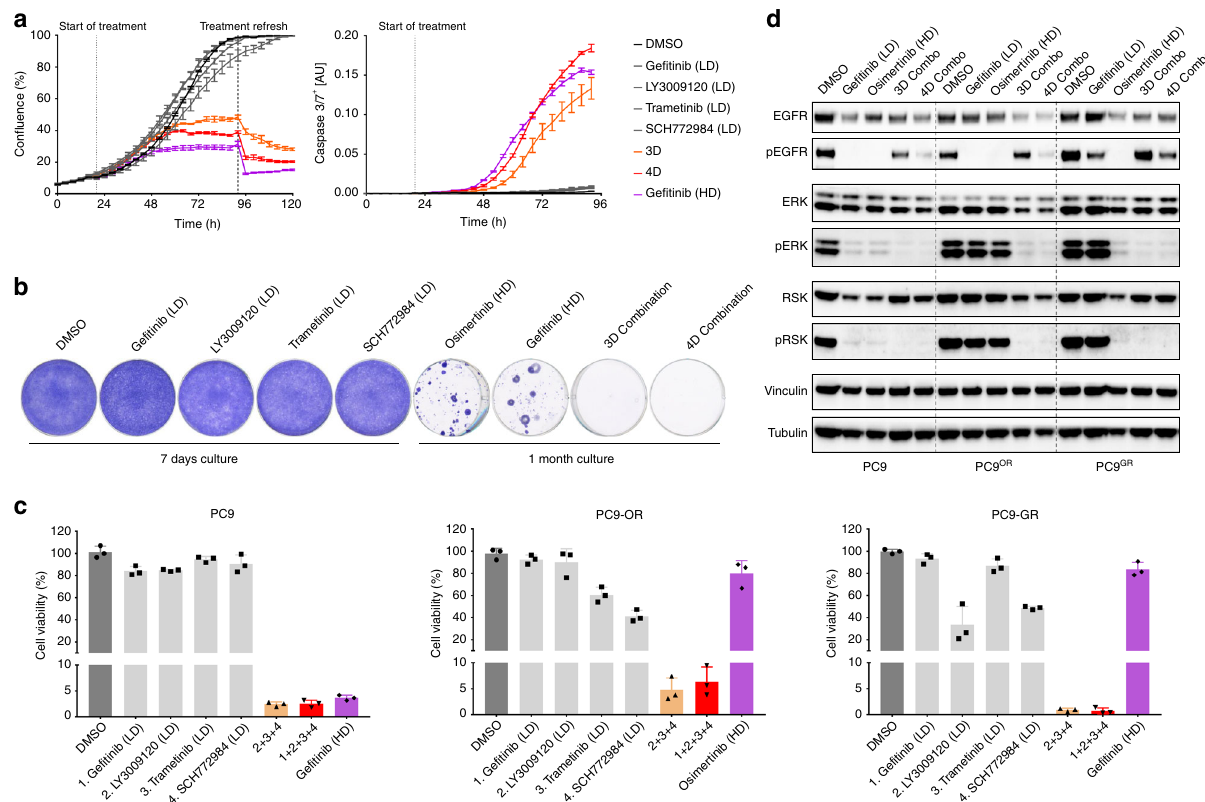
Fig. 2 MLD therapy minimises therapeutic resistance and is effective in EGFRi-resistant PC9 cells. a MLD therapy abrogates cell proliferation and induces apoptosis in PC9 cells. PC9 cells were plated and incubated overnight to allow attachment to the plate. Cells were then treated with DMSO, with EGFR, RAF, MEK, ERK inhibitors at low dose, with 3D Combo (RAF + MEK + ERK inhibitors at LD) or with 4D Combo (EGFR + RAF + MEK + ERK inhibitors at LD) and placed in the IncuCyte ® . Con fl uence (left) and caspase 3/7 activation (right) over time was measured by the IncuCyte ® . Standard error of the mean (SEM) from 3 replicates is plotted. b MLD therapy prevents the acquisition of drug resistance in PC9 cells. PC9 cells were cultured with DMSO, with EGFR, RAF, MEK and ERK inhibitors at low dose (for 7 days) and with high dose (HD) of Osimertinib (200 nM), HD of Ge fi tinib (280 nM) and with 3D and 4D Combinations (for 1 month), after which plates were stained and scanned; A representative image from 3 biologically independent replicates is displayed. c EGFRi-resistant PC9 cells remain sensitive to MLD therapy. PC9, PC9-OR (Osimertinib-resistant) and PC9-GR (Ge fi tinib- resistant) cells (see methods) were cultured with DMSO, with low doses of EGFR, RAF, MEK or ERK inhibitors, with 3D or 4D combinations or with HD of Ge fi tinib or Osimertinib for 4 days, after which cell viability was measured using CellTiter-Blue ® . Standard deviation (SD) from 3 biologically independent replicates is plotted. d MLD therapy blocks MAPK pathway in EGFRi-resistant PC9 cells. PC9, PC9-OR and PC9-GR cells were cultured with DMSO, HD of Osimertinib, HD of Ge fi tinib or with 3D or 4D combinations. Protein for western blotting was harvested after 24 h of treatment; The level of pathway inhibition was measured by examining pERK and pRSK protein levels and the level of EGFR inhibition was measured by examining pEGFR protein levels in the western blot. Tubulin and Vinculin were used as loading